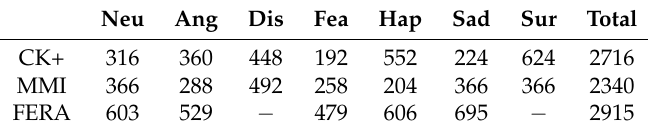
Table 2. The number of input images as emotions and